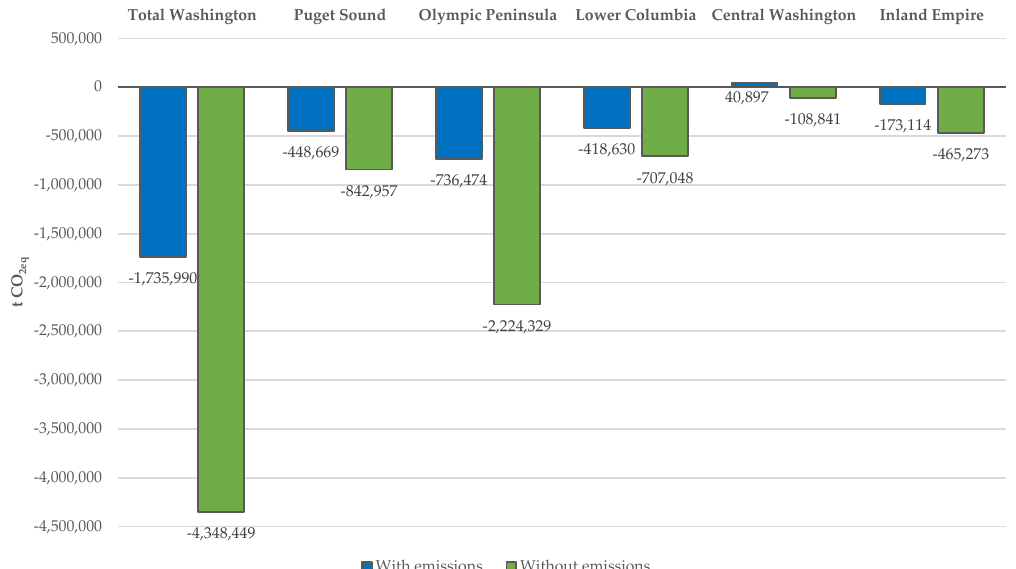
Figure 5. Global warming mitigating role of wood products in 2015 from private forests in Washington State. Results include the scenario where fossil fuel-based life cycle emissions from wood products manufacturing are included (blue) and excluded (green). The global warming potential is calculated over a 100-year timeframe.